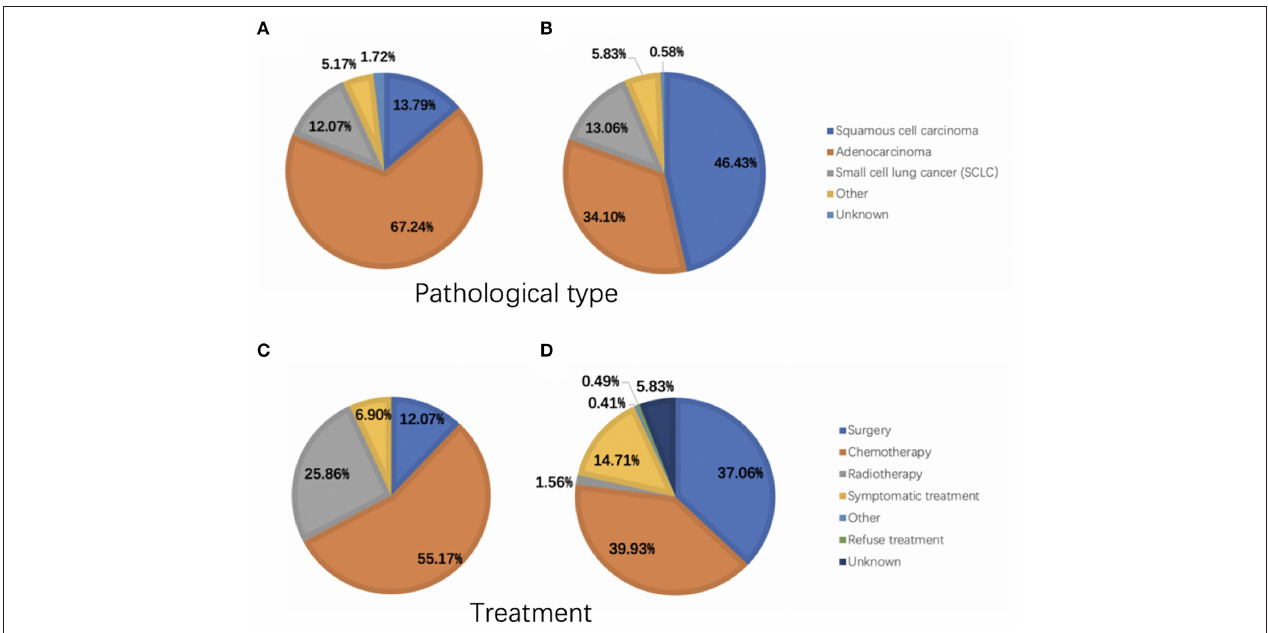
FIGURE 3 | Pathological tumor types and treatment of patients in the OM and NM groups. (A) The pathological type of OM group. (B) The pathological type of NM group. (C) The treatment of OM group. (D) The treatment of NM group. OM, ocular metastasis; NM, no metastasis.